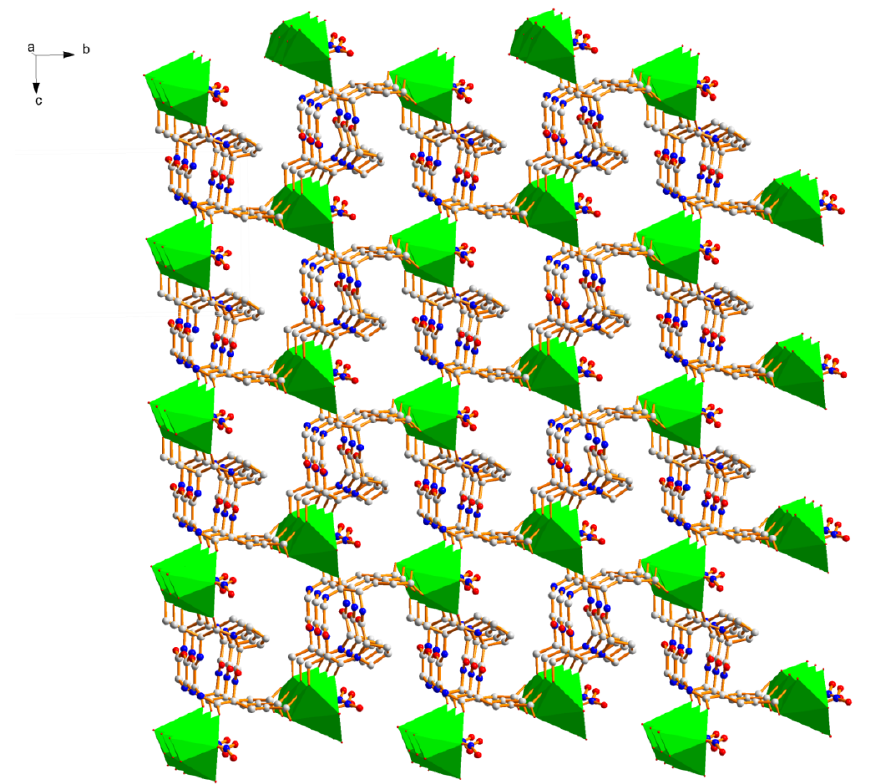
Figure 5. Polyhedral view in three-dimensional structure of 2 . Color code: green, Pb; gray, C; blue, N; red,